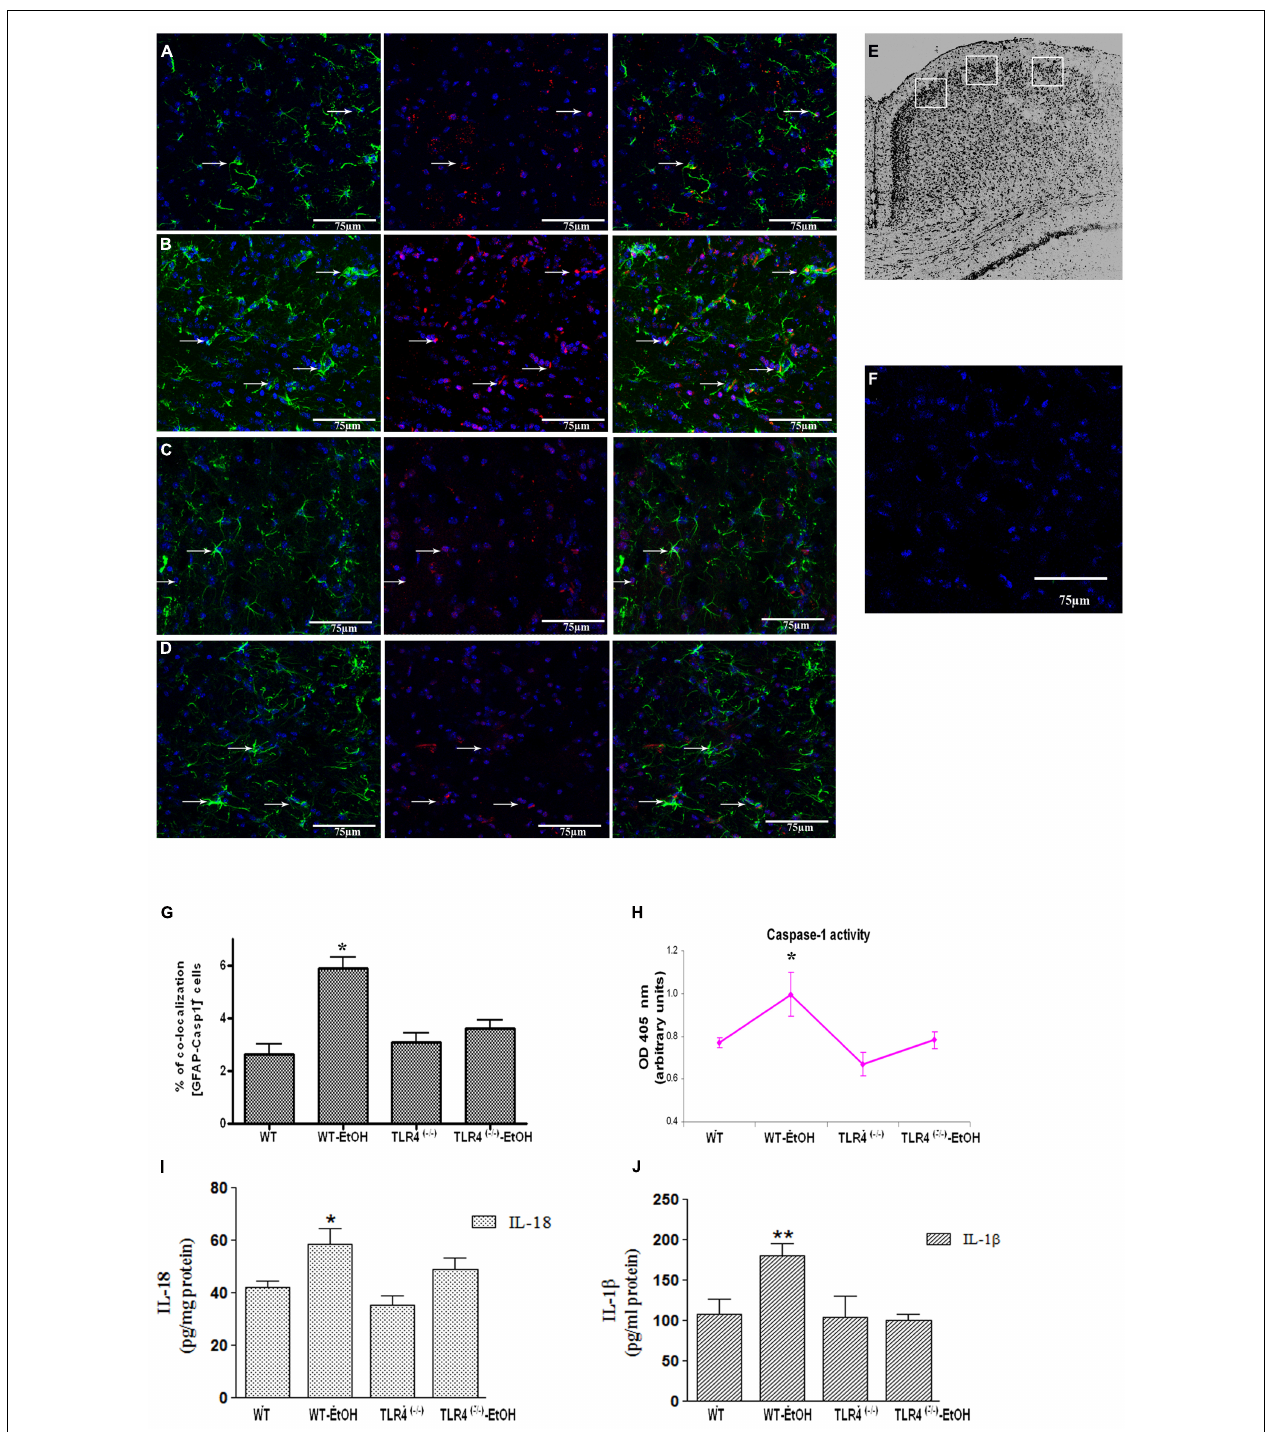
FIGURE 1 | Chronic ethanol intake increases caspase-1 activity in cortical astroglial cells ofTLR4 mice. (A–D) Confocal images illustrate the co-localization of caspase-1 (red) with GFAP (green) in the cortex area (E) of TLR4 + / + (A,B) andTLR4 − / − (C,D) mice (arrows indicate co-localization of the Casp-1 and GFAP-positive cells). (F) Confocal negative controls, in the absence of primary antibodies.We used four independent biological replicates from each experimental condition. Scale bar: 75 μ m. (G) The quantitative analysis shows the percentage of the increased number of